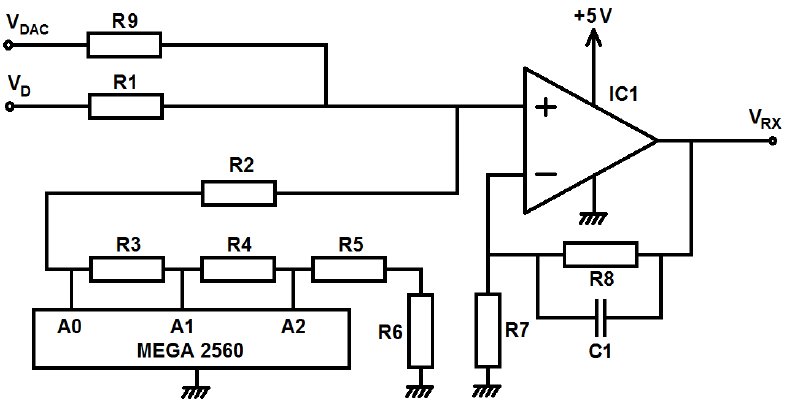
Figure 12. Simplified schematic of the receiver signal